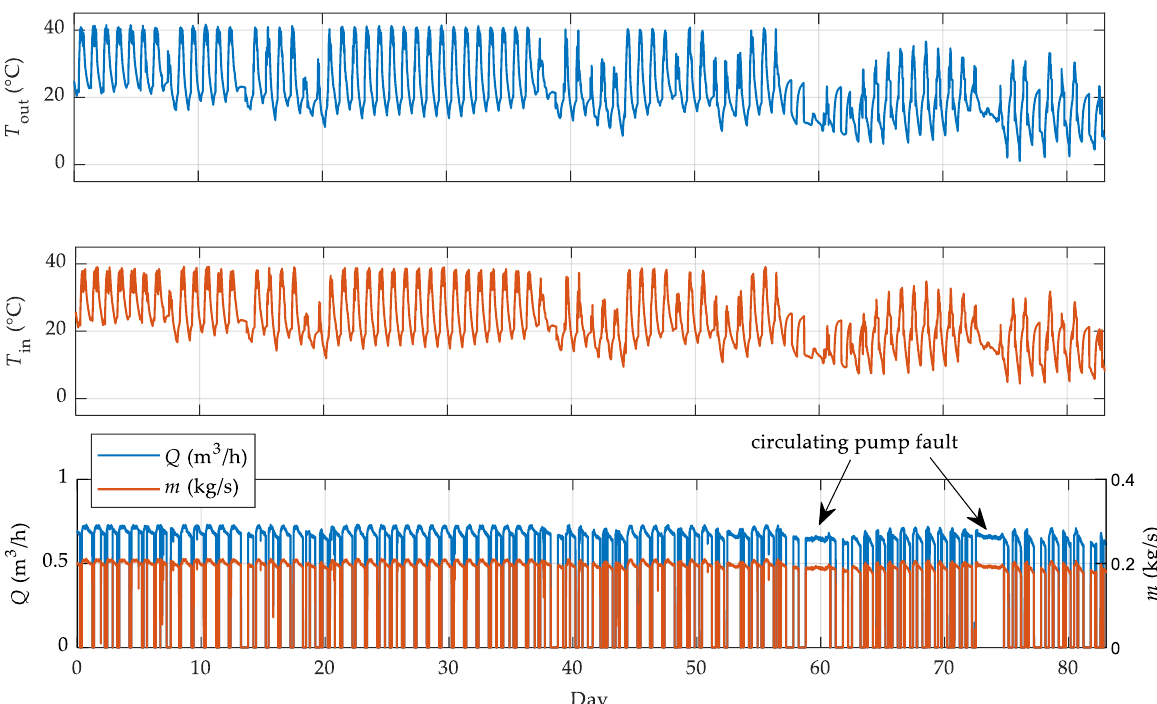
Figure 6. Temperature measurements on the outlet ( T out ) and inlet ( T in ) side of the PV/T collectors and mass ( m ) and volume ( Q ) flow of the working medium for 83 days (from August to October 2021).